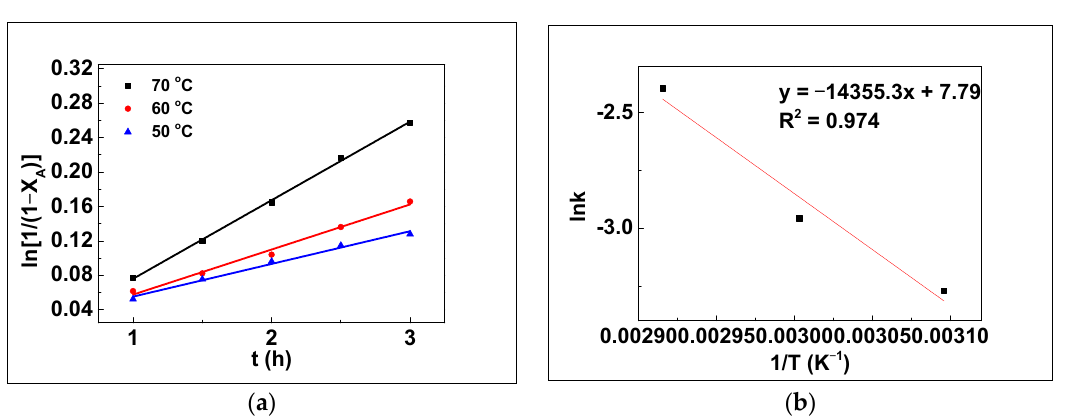
Figure 6. Pseudo- fi rst-order fi ts for oxygenation of ethylbenzene with H 2 O 2 catalyzed by T(2,6- Figure 6. Pseudo-first-order fits for oxygenation of ethylbenzene with H 2 O 2 catalyzed by T(2,6- diCl)PPFe ( a , b ). diCl)PPFe ( a , b ). Table 6. The pseudo- fi rst-order kinetic parameters in ethylbenzene catalytic oxygenation. Table 6. The pseudo-first-order kinetic parameters in ethylbenzene catalytic